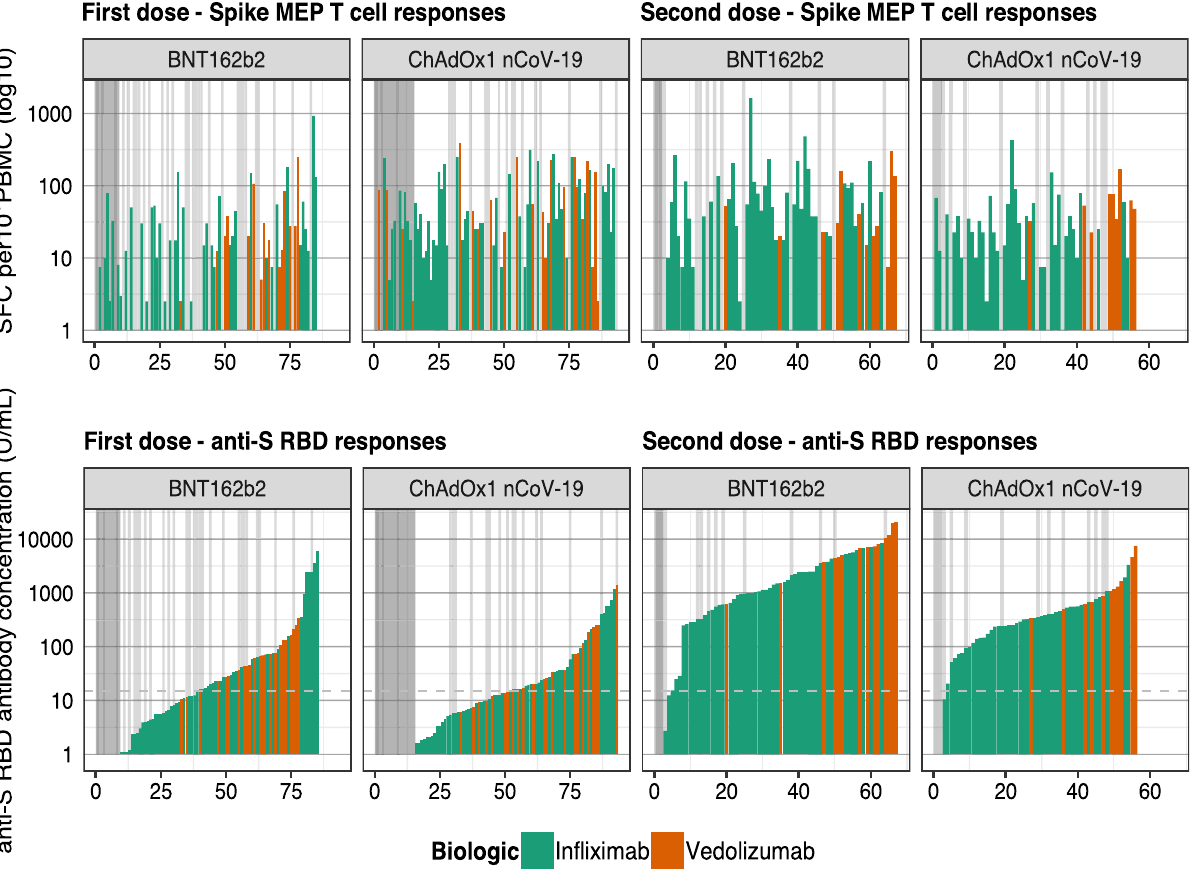
Fig. 4 Anti-spike T cell responses ordered by the cumulative magnitude of anti-S RBD following two doses of the BNT162b2 or ChAdOx1 nCoV-19 vaccine show uncoupling of the T cell and antibody responses. Top panel shows T cell responses to spike, and the bottom panel shows anti-S RBD responses plotted for individual study participants ordered by increasing magnitude of anti-S RBD antibody concentration (U/mL). The vertical dark grey bars at the LHS of the panels indicate individuals with no anti-S RBD response. The vertical light grey bars in the panels indicate individuals with no T cell response. The horizontal dotted line represents a threshold shown of 15 U/mL of anti-S RBD. Source data are provided as a Source Data fi le. LHS left-hand side, MEP mapped epitope peptide, SFC spot forming